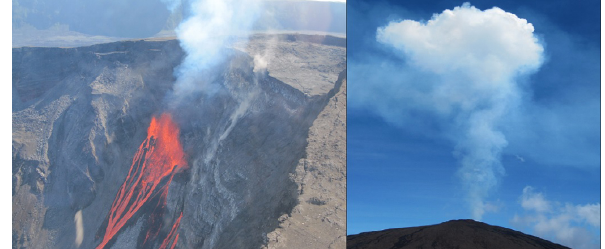
Figure 1. January 2010 summit eruption of Piton de la Fournaise: the 60m long fissure on the inner cliff of Dolomieu summit crater emits lava flows towards the bottom of the caldera. The < 30m high fountains (left) are the source of the ca. 1km high vertical plume (right) of gas and vapour. Transport and sedimentation of solid par- ticles are mostly confined to the lowest portion ( < 100m) of the plume. Pictures provided by the Piton de la Fournaise Volcanologi- cal Observatory (OVPF/IPGP).